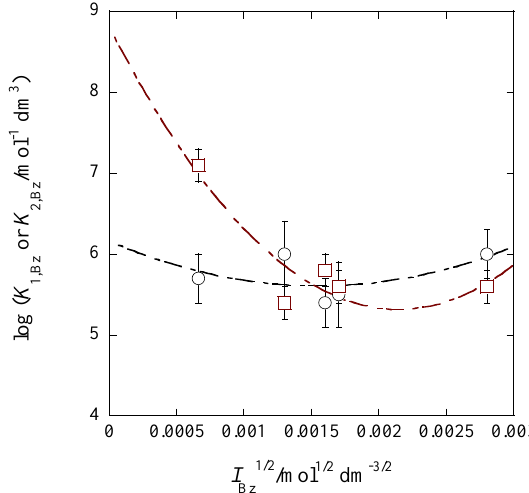
Figure 7. Plots of log K 1,Bz (circle) and log K 2,Bz (square) versus I Bz1/2 for the Pb(II) extraction with Cd(NO 3 ) 2 and B18C6 into Bz. The regression lines were based on Equations (14b) and (15b). In comparison of Equations (14a) and (15a) with Equations (14b) and (15b), the point of intersection changed from I Bz1/2 /mol 1/2 · dm − 3/2 = 0.002 7 to 0.003 3 , while their corresponding log K 1,Bz (=log K 2,Bz ) value changed from 5.3 to 6.3.